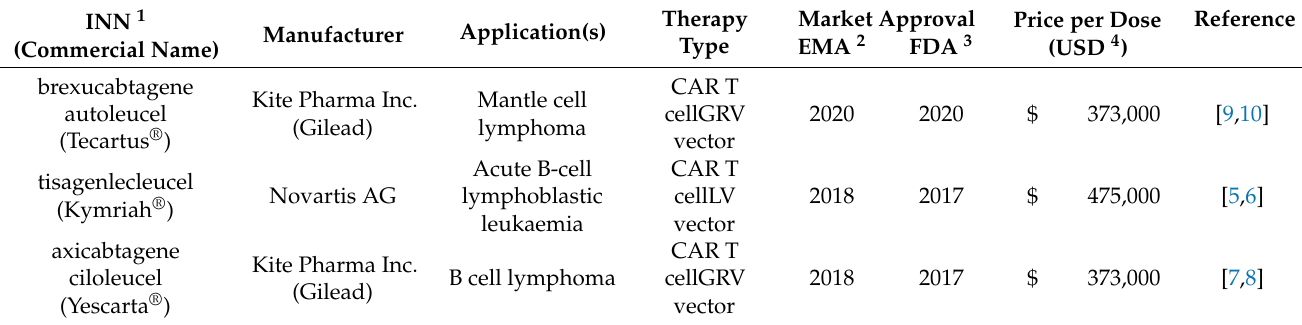
Table 1. EMA and FDA approved gene-modified T cell therapies (accessed on 4 January